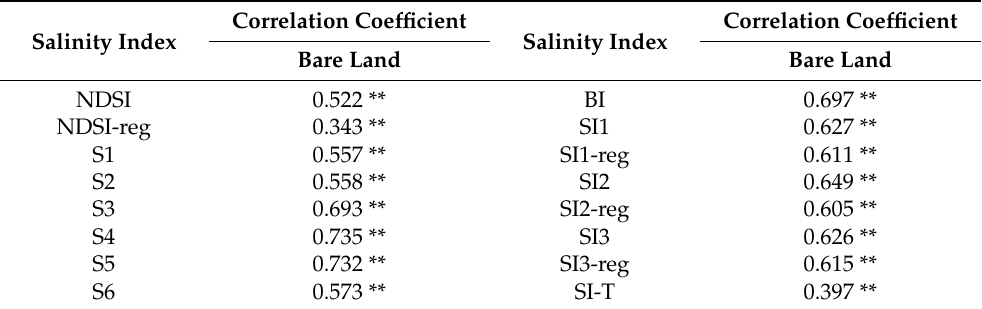
Table 5. The correlation between the soil salt index of the bare land and the soil salt content.